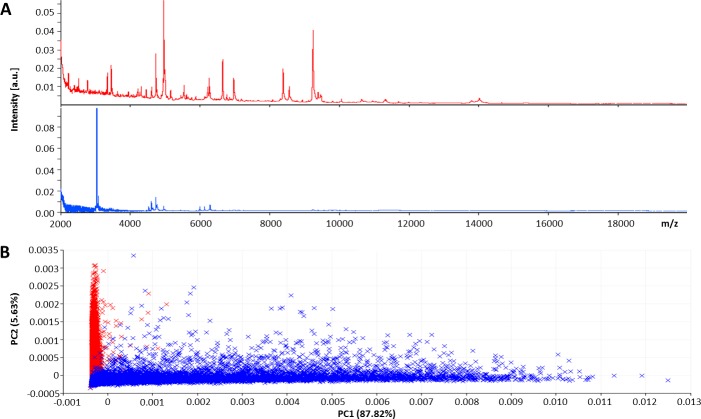
A) Average mass spectra and B) PCA scores plot of MeLiM melanoma (blue) and healthy skin (red) tissue cryosections.